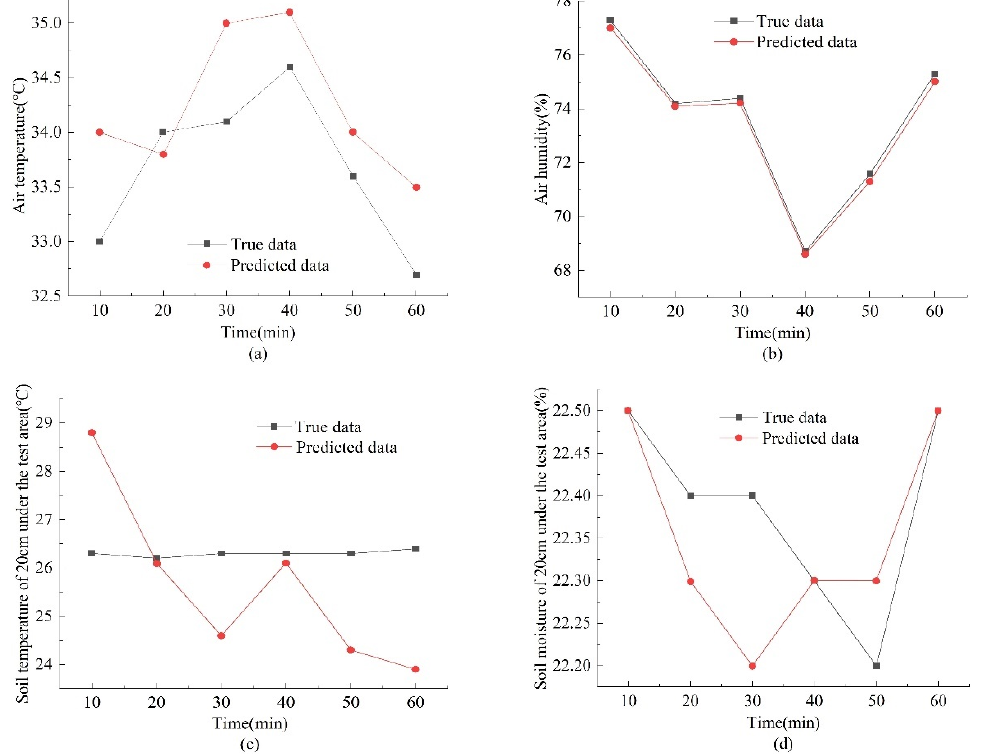
Figure 10. Variations in the loss function results for various sensors.